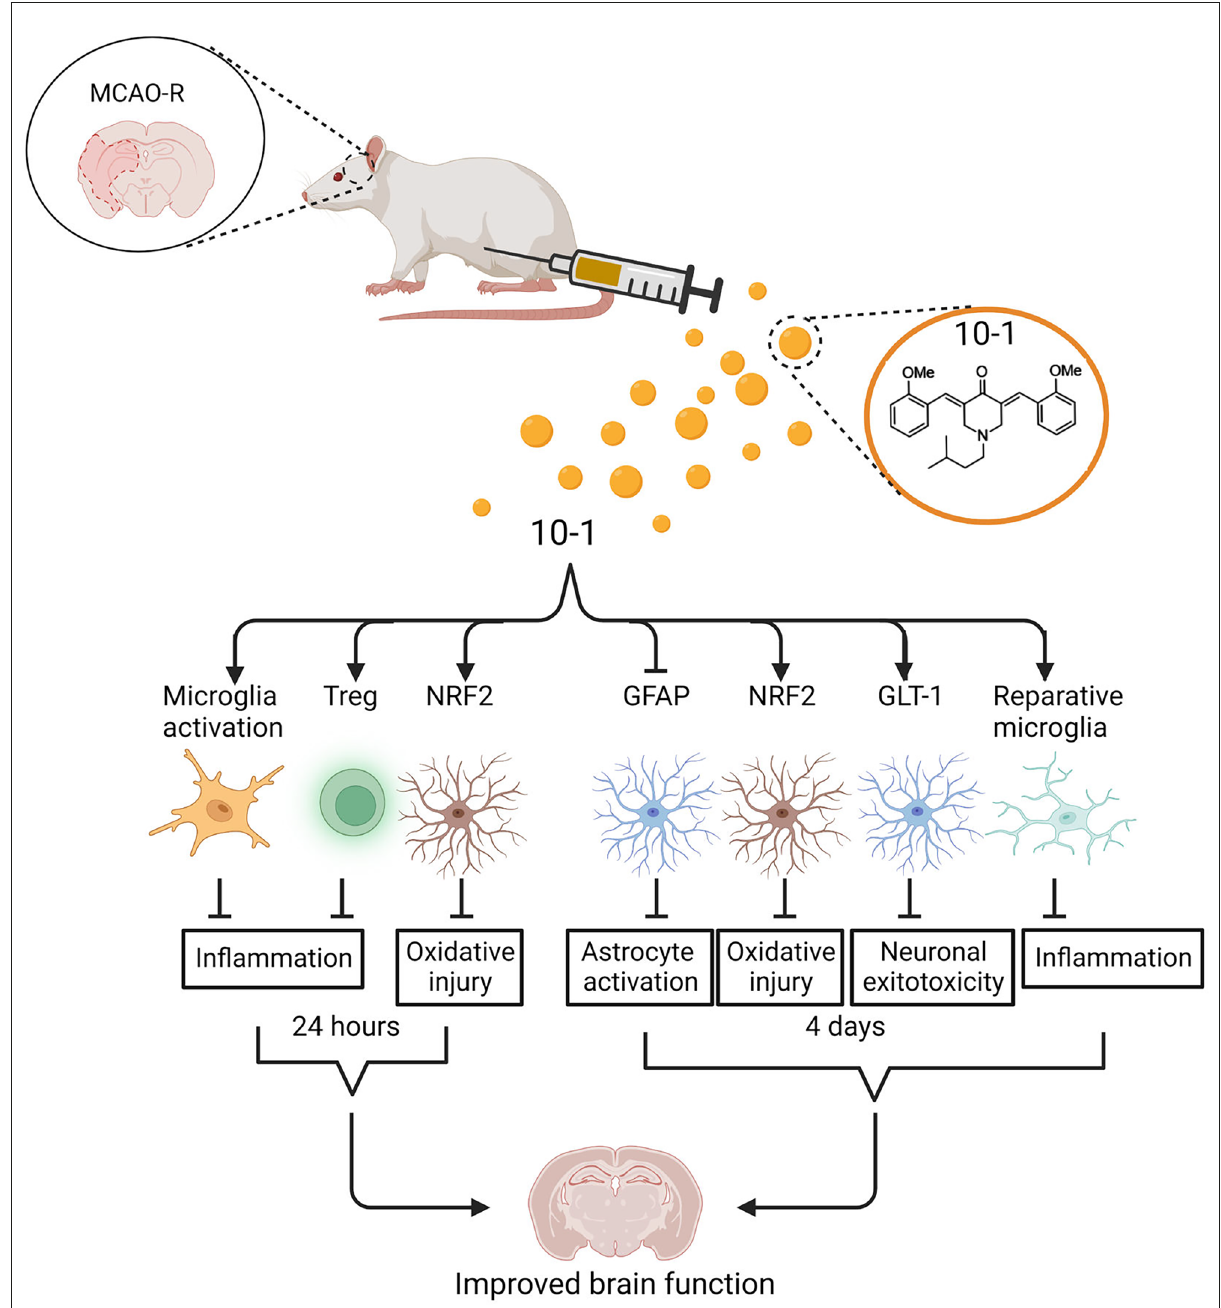
FIGURE5 Schematic of regulation of ischemic stroke injury following 10-1 treatment. 10-1 treatment attenuated neuronal injury following robust transient activation of microglia, increased Treg numbers, and increased representation of NRF2 positive astrocytes 24 h after ischemic injury. Four days after ischemia injury, the 10-1 therapy also enhanced NRF2 positive astrocytes, polarized M2 reparative microglia, and reduced astrogliosis. Created with